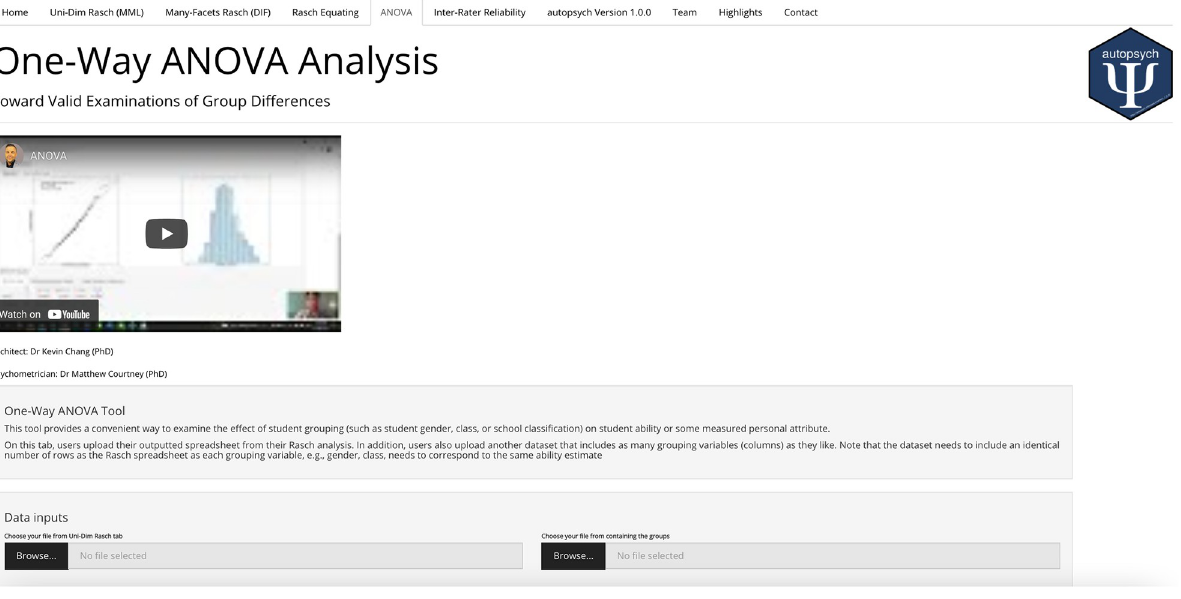
Fig 16. One-way ANOVA function.